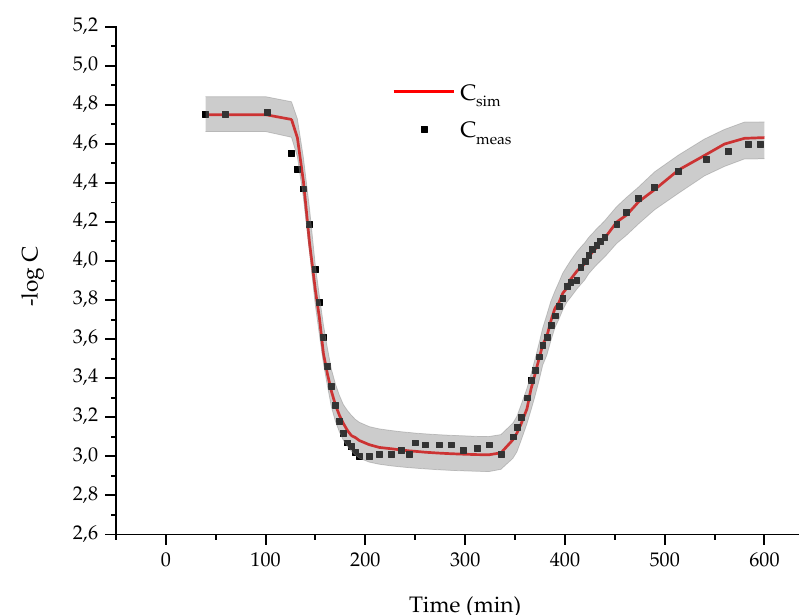
Figure 8. Observed (symbols), calibrated (lines), and predictive uncertainty (grey band) for the effluent bromide concentration using the mobile-immobile transport model.